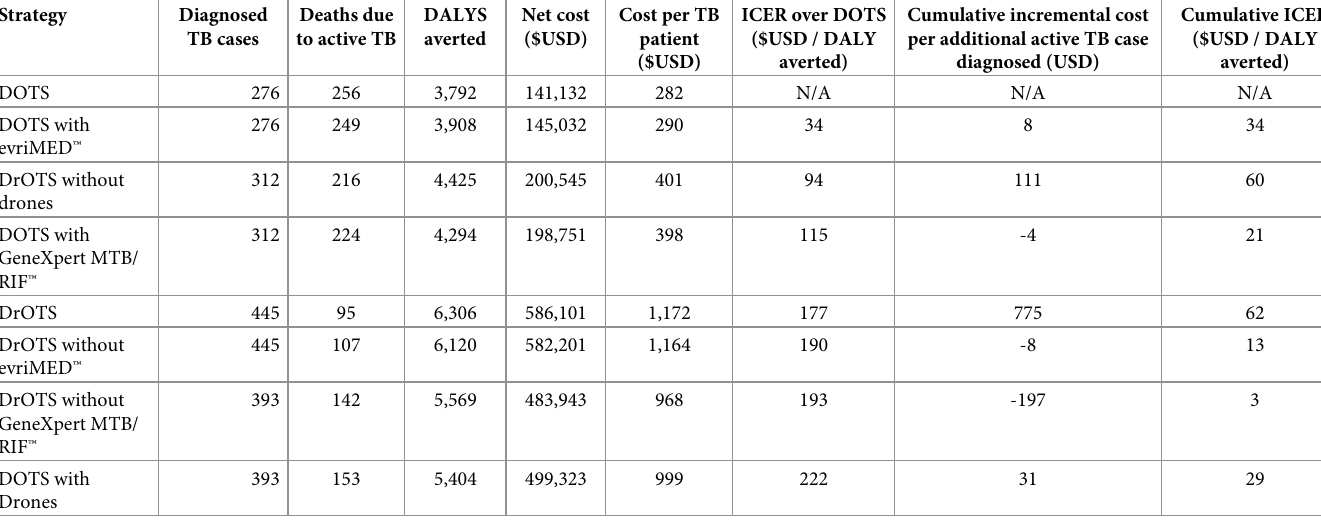
Table 5. Cost-effectiveness of DOTS, DrOTS and modified strategies for TB control in a 200,000-population remote district of Madagascar.